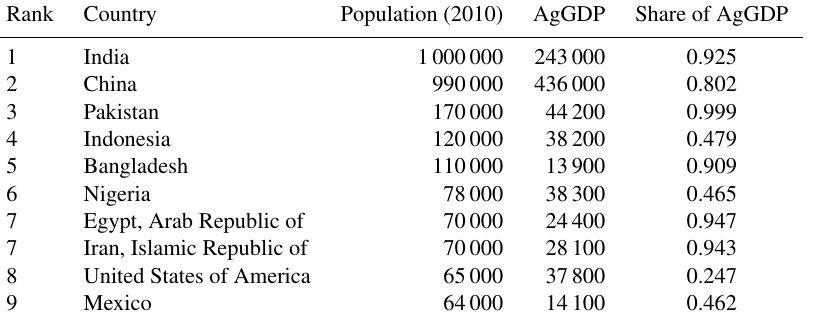
Table B6. Top 10 countries of 2010 population exposed to WCI ar- eas with agricultural GDP (millions of USD) and population (thou-